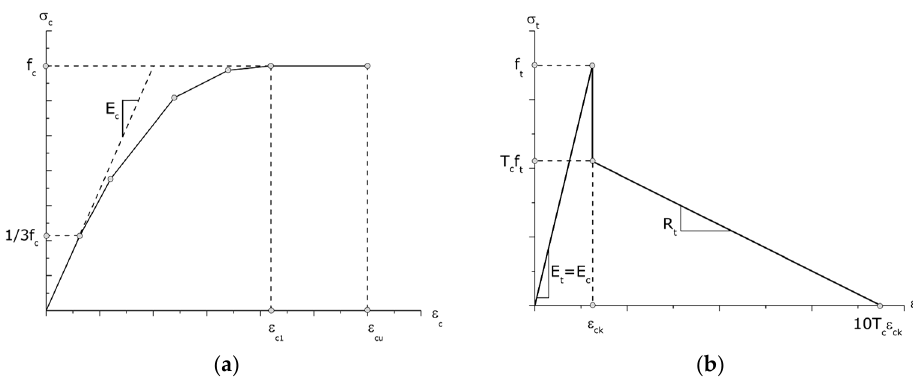
Figure 9. Stress–strain relations for concrete ( a ) in compression; ( b ) in tension.